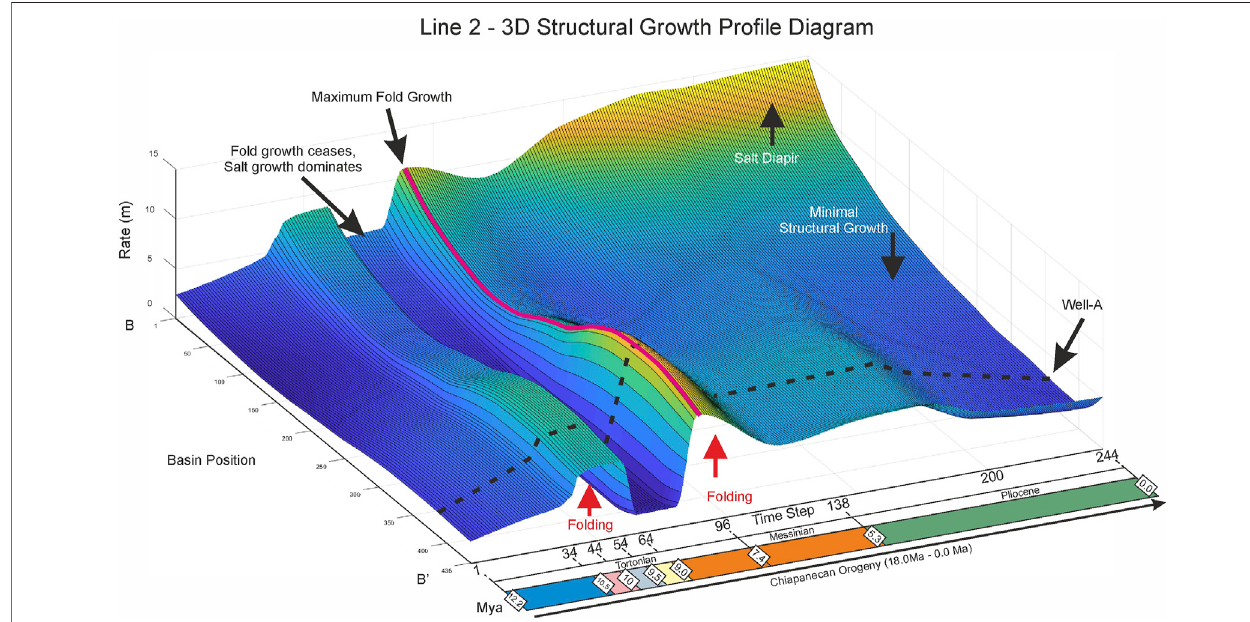
FIGURE 9 | 3D representation of the rate of rise of the Structural Growth Pro fi le through time. X – axis represents position in time, Y – axis represents basin position along Line 2, Z – axis showing the rate of rise in meters per Time-Step. Diagram shows the combination of two Structural Growth Pro fi les through time. Pro fi le 1 was consistent with compressional folding over High-1, Pro fi le 2 is focused on salt diapirism and withdrawal at High-2. Fold growth (Pro fi le-1) dominates in two distinct phases, phase one occurs from 12.2 Ma until ceasing at 9.0 Ma, at this point Pro fi le 2 (salt growth) dominates until 7.8 Ma, at which point compressional folding begins again. Pro fi le 1 continues to dominate until the middle Pliocene when fold growth tapers off. At this point, salt tectonics dominates, represented by Pro fi le 2.